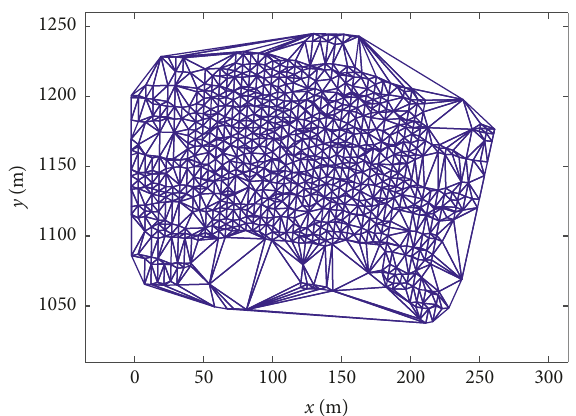
Figure 10: Delaunay TIN constructed based on the PSC points.